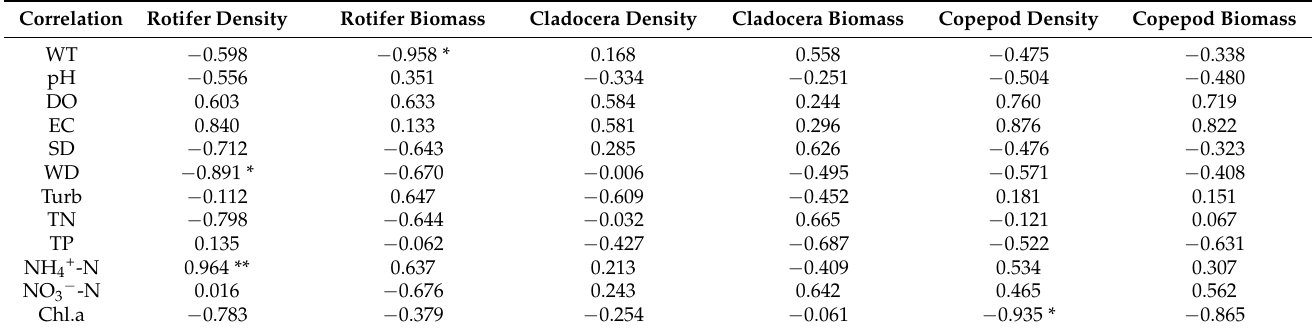
Figure 10. Comparison of biomass and density distribution of zooplankton in Lake Chen Yao and Lake Feng Sha.